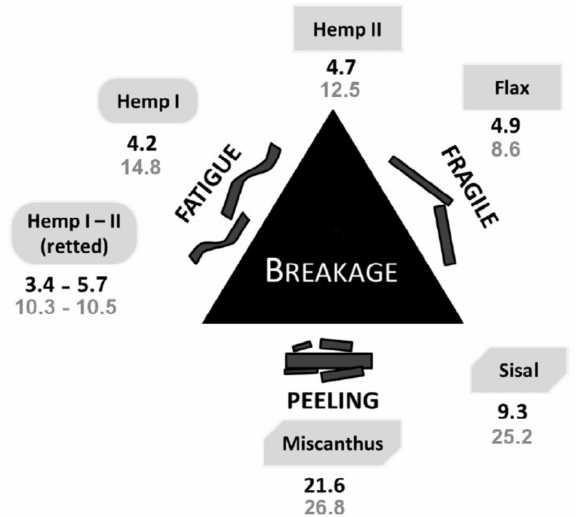
Figure 2. Different breakage mechanisms of natural fibres during compounding in a thermoplastic polymer melt. The numbers in black indicate Klason lignin content and, in grey, hemicellulose mass% content